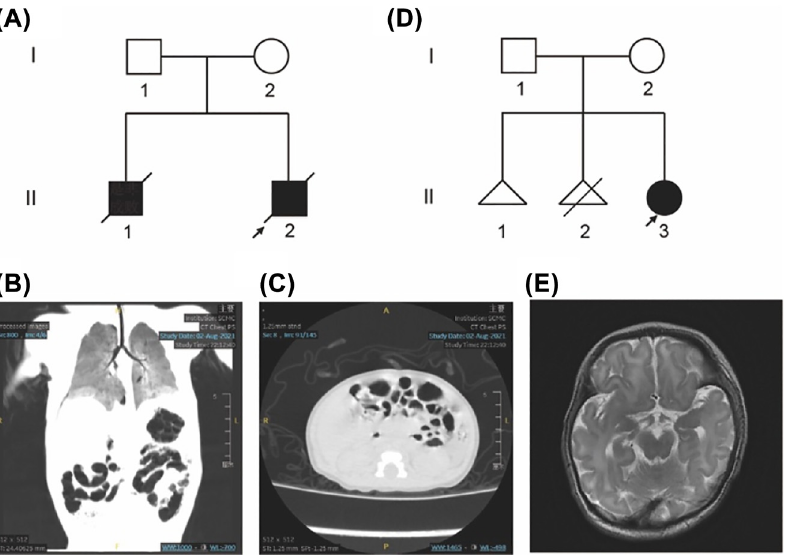
Figure 1: Pedigree of the family. Thefilledblacksymbolsrepresenttheaffectedmembers,andthearrowdenotestheproband.Theblackcircledenotesabortedbabies.(A)The pedigree of family 1, II-2 was patient 1. (B) The pedigree of family 2, II-1 was a natural abortion, II-2 was aborted because of no fetal heart rate, andII-3 was patient2. Patient1 ’ s chestCT withpneumothorax (C) andpneumatosisintestinalis(D).(E)Patient 2 ’ s cranial CT showedsubdural